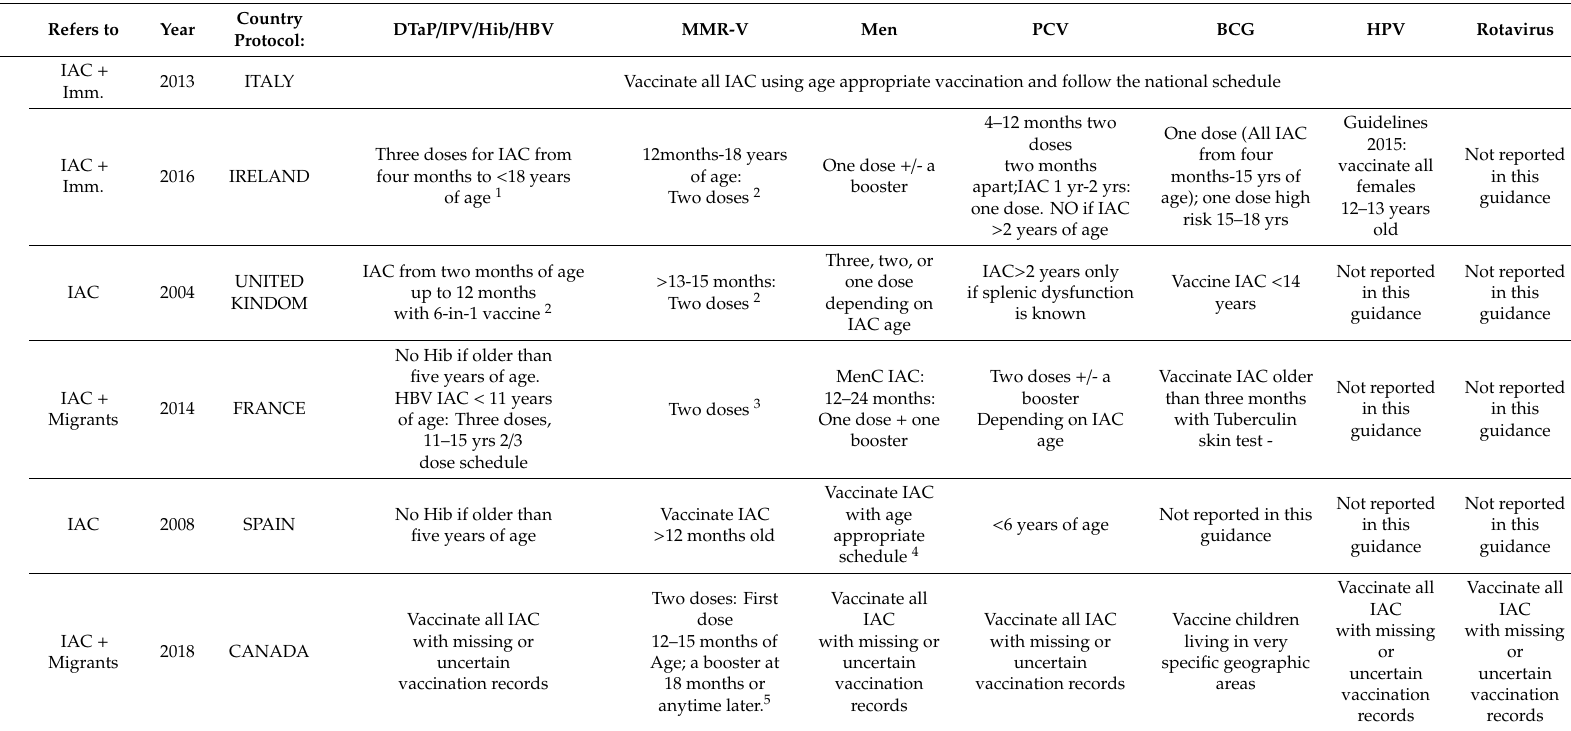
Table 2. Vaccinations recommended by di ff erent Western countries for newly arrived Internationally Adopted Children (IAC). Country Refers to Year